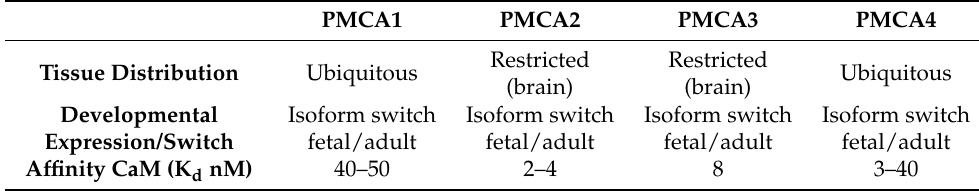
Table 1. Properties of PMCA isoforms. Modified based on